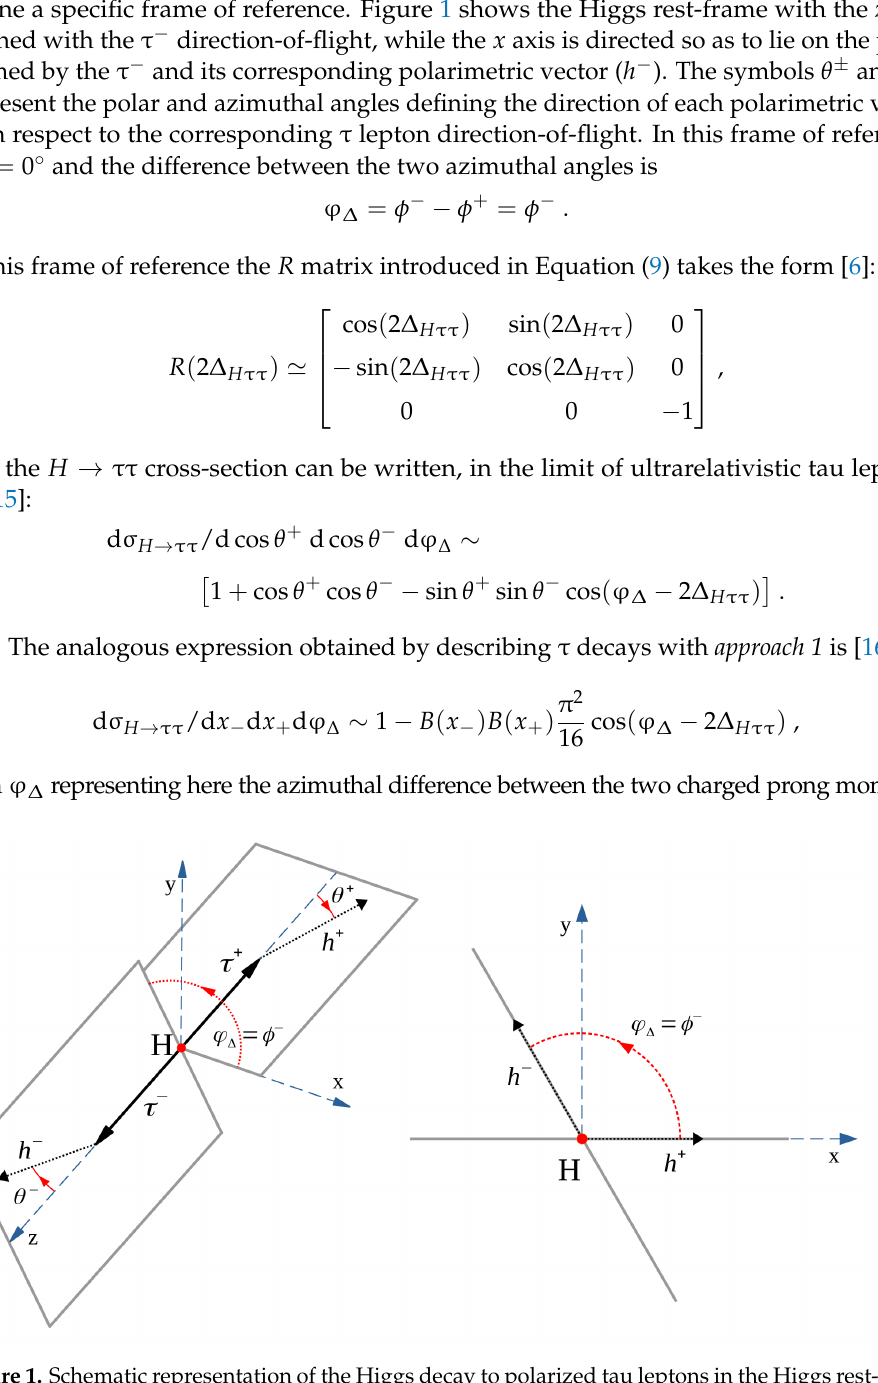
Figure 1. Schematic representation of the Higgs decay to polarized tau leptons in the Higgs rest-frame. On the left, the three-dimensional view is shown, while on the right a projection on the x–y plane is presented in order to define the angles used in Equations (14) and (15). The blue dashed lines represent the right-handed Cartesian axes, while the tau lepton momenta and polarimetric vectors are shown in black. The polar angles with respect to the z axis, and the azimuthal angle spanned by the tau decay planes (in gray) are shown in